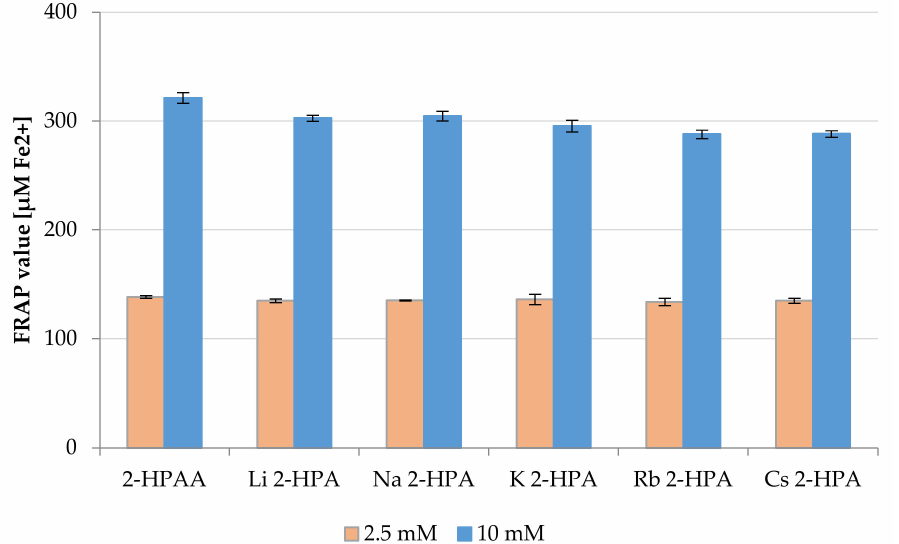
Figure 8. Antioxidant properties of the 2-HPAA and its alkali metal salts expressed as FRAP value ( µ M Fe 2+ ) (concentrations of tested substances in the samples 2.5 and 10 mM).